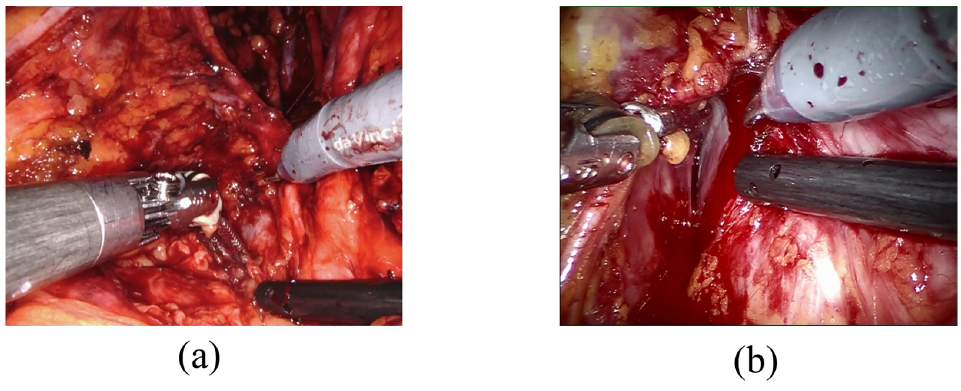
Figure 1. Examples of blood residue on tissues ( a ) and active bleeding ( b ).